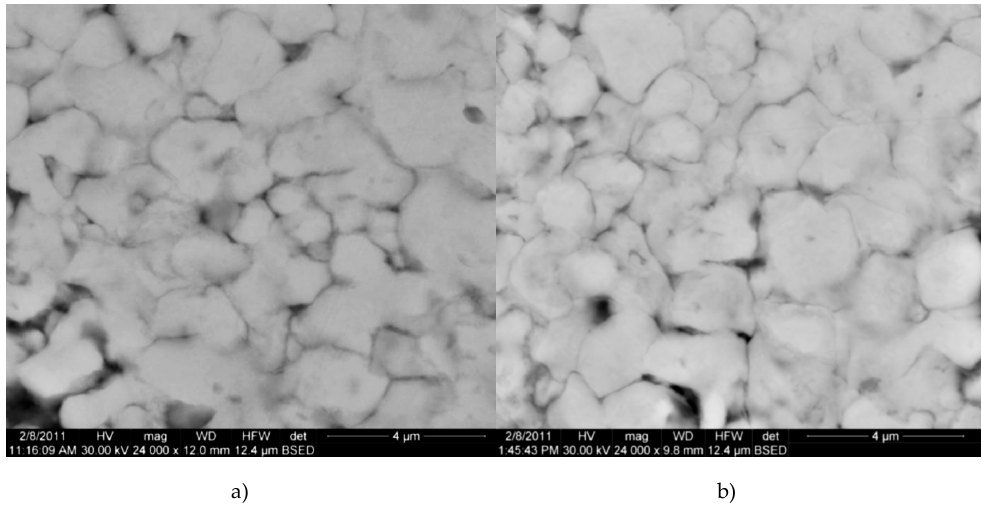
Figure 4. BSED microscopy images of the samples compacted at 500 MPa. ( a ) Cu-15%Fe 3 O 4 and ( b ) Cu-20%Fe 3 O 4.